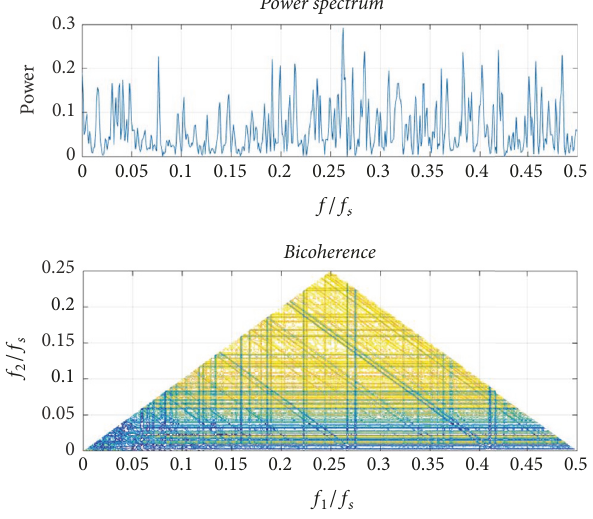
Figure 9: Bicoherence plots of NCS ( 𝑎 ̸= 0, 𝑏 ̸= 0 ).